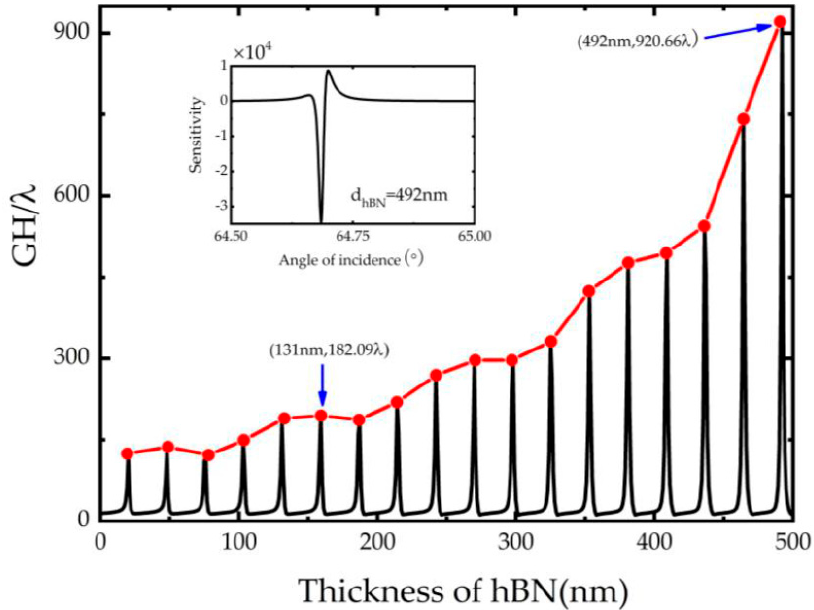
Figure 4. Dependence of GH shift on the thickness of hBN, in which Fermi energy E F = 0.2 eV, Ag thickness d 2 = 15 nm, Au thickness d 3 = 20 nm, graphene layer N = 1 and the inset is the sensitivity curve at d 3 = 492 nm.